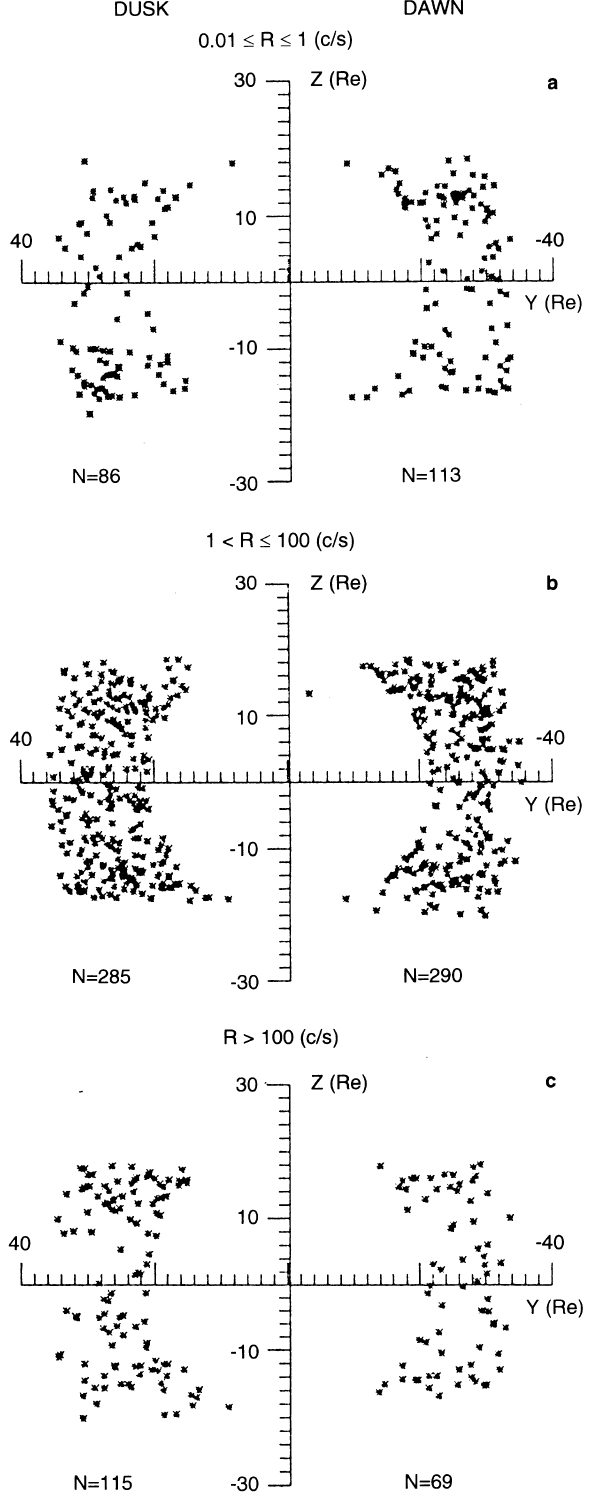
Fig. 4a–c. Projection on the Y - Z plan of the positions at which ion bursts were detected for three di(cid:128)erent ranges of the counting rates. More intense bursts were detected in the